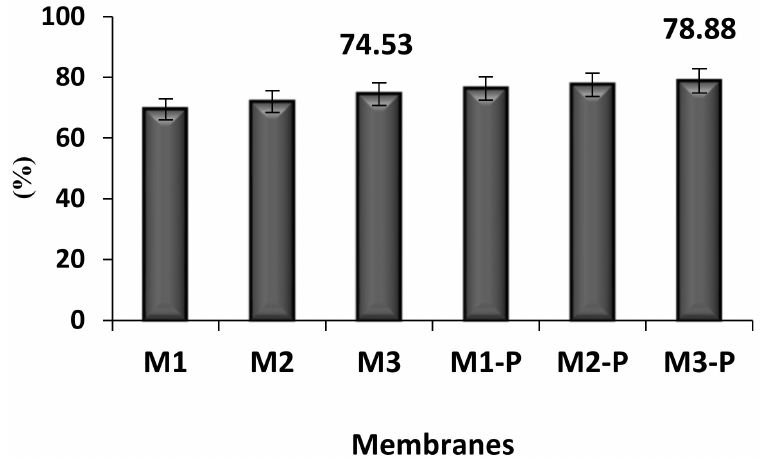
Figure 9. Turbidity clearance percentage of all tested HF membranes after filtration of lake water ( n =